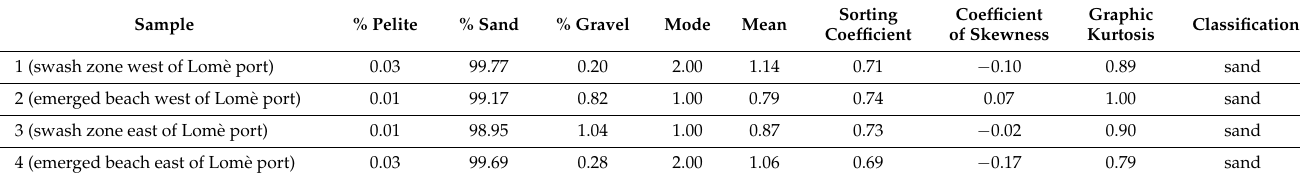
Table 1. Sediment grain size parameters of the samples collected in the Lom é